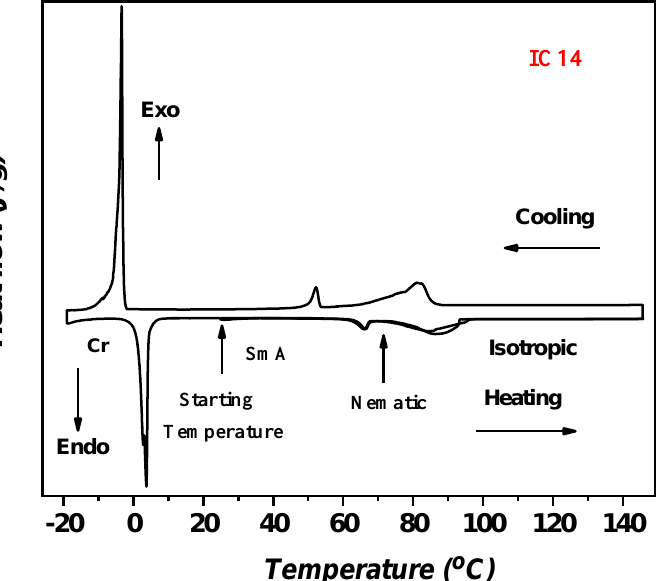
Figure 1. DSC heating/cooling cycles of I/C14 ionic liquid crystal (ILC) sample bearing MeO polar group and alkyl chain length of C14.